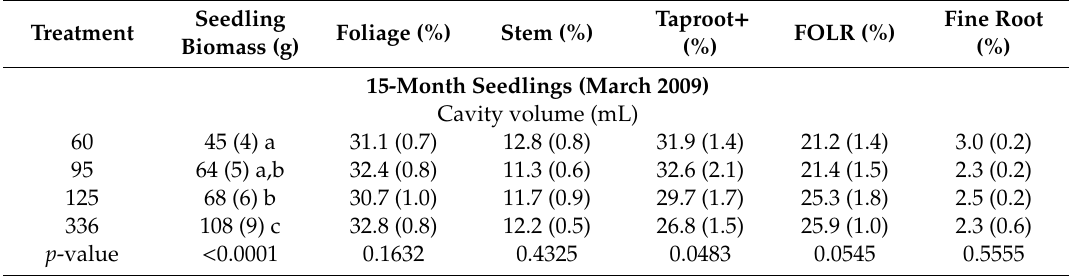
Figure 4. Longleaf pine seedling stem diameter, expressed as root collar diameter (RCD) at outplanting (Y0), ground-line diameter (GLD) in Year 1 (Y1) and Year 3 (Y3), and diameter at breast height (DBH) in Year 5 (Y5) and Year 8 (Y8), in response to nursery treatments. ( a ) Cavity volume; ( b ) nitrogen rate: low (LN), medium (MN), and high (HN); and ( c ) copper (Cu) root pruning. Within a treatment and year, the same letter indicates no significant di ff erences at the Bonferroni-adjusted 0.05 level. Error bars represent 1 SE. Table 3. Means (1 SE) and p -values for the seedling biomass and its allocation to seedling components in response to nursery treatments. Seedlings were excavated 15 and 22 months after outplanting. The seedling components are as follows: taproot + , taproot plus all sinker roots and all adventitious roots; FOLR, first-order lateral root; and fine root, non-FOLR from taproot within the root plug. Within each treatment and excavation, means followed by the same letter are not significantly di ff erent at the Bonferroni-adjusted 0.05